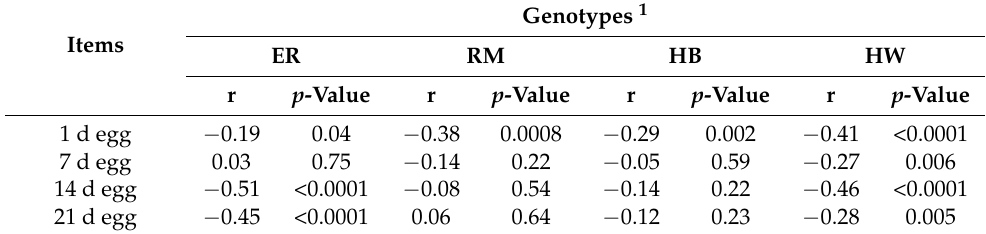
Figure 5. Effect of genotype 1 on Haugh Units (HU, lsmeans ± SE) according to storage time throughout the laying period. Different letters among columns per each storage time indicate different values: a, b: p < 0.05; A, B: p < 0.01. 1 Genotype: ER: Ermellinata di Rovigo; RM: Robusta maculata; HB: Hy-Line Brown; HW: Hy-Line White 36. 2 Observations ( n ) at 1 d: ER, HB, HW (114), RM (93); at 21 d: ER (92), RM (76), HB (104), HW (100). Table 7. Pearson’s correlation between albumen pH and height in fresh and stored